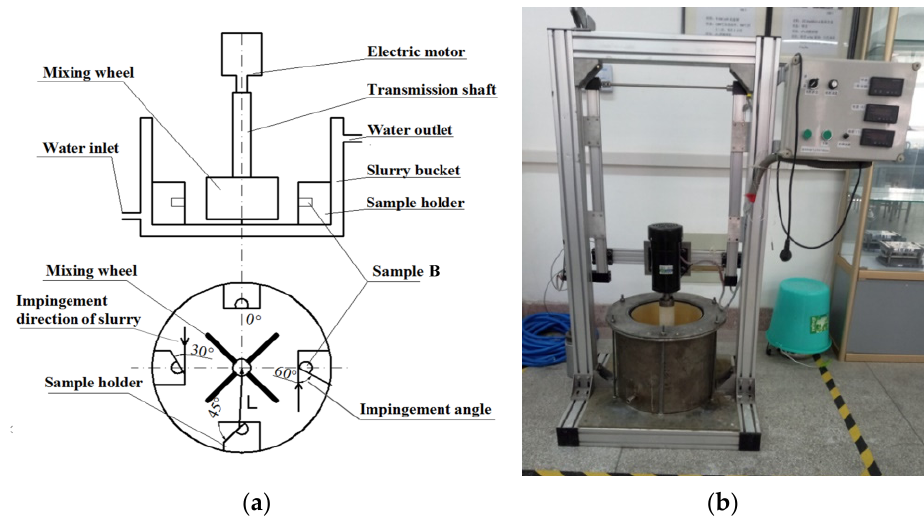
Figure 2. Structure drawing of erosion–corrosion test equipment: ( a ) structure drawing; ( b ) physical map.